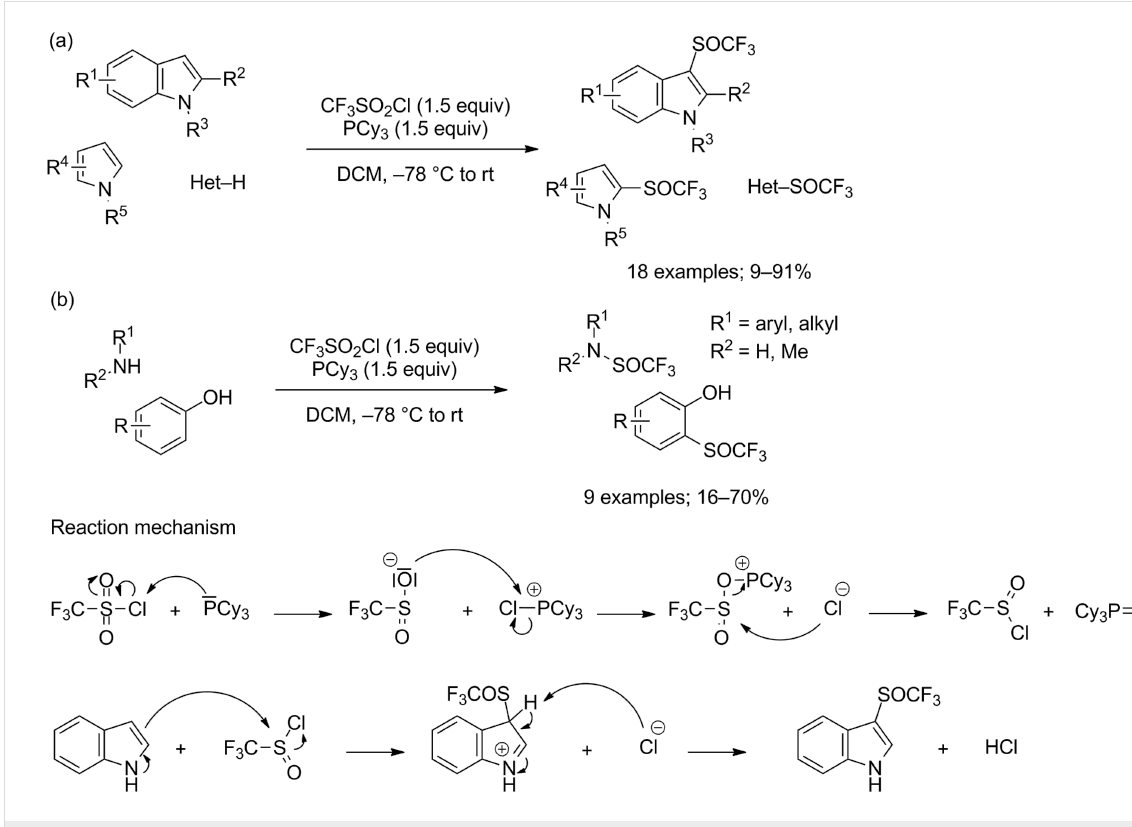
Scheme 38: PCy 3 -mediated trifluoromethylsulfinylation of azaarenes, amines and phenols.